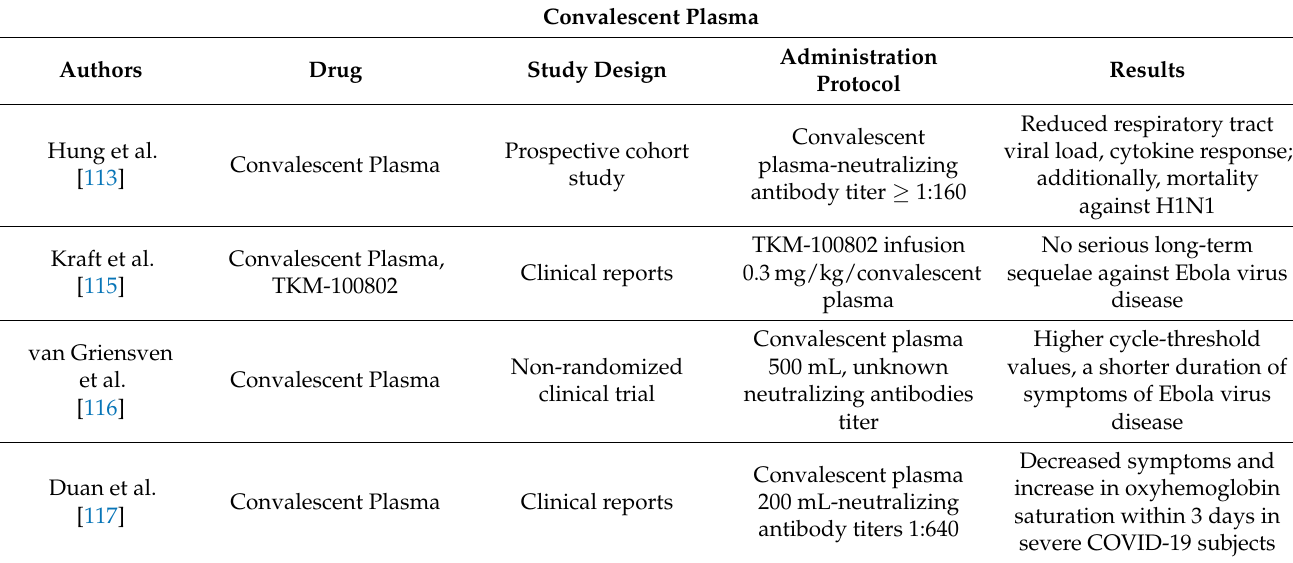
Table 4. Summary of the in vivo studies included about convalescent plasma treatments for viral